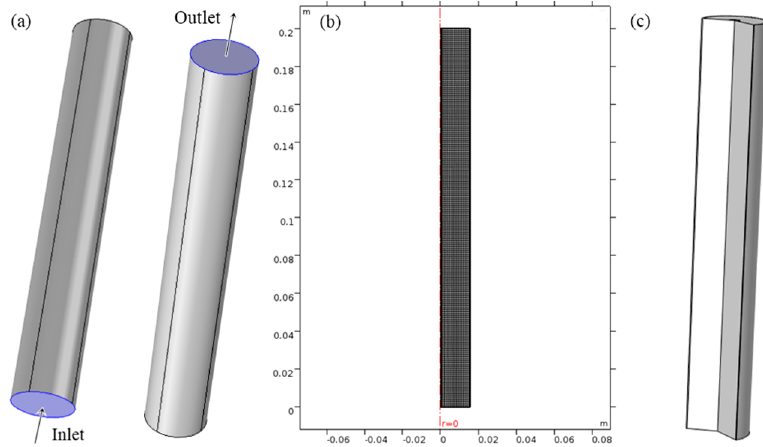
Figure 8. ( a ) Schematics of adsorption column; ( b ) refined mesh with axis of symmetry; ( c ) full model geometry. model